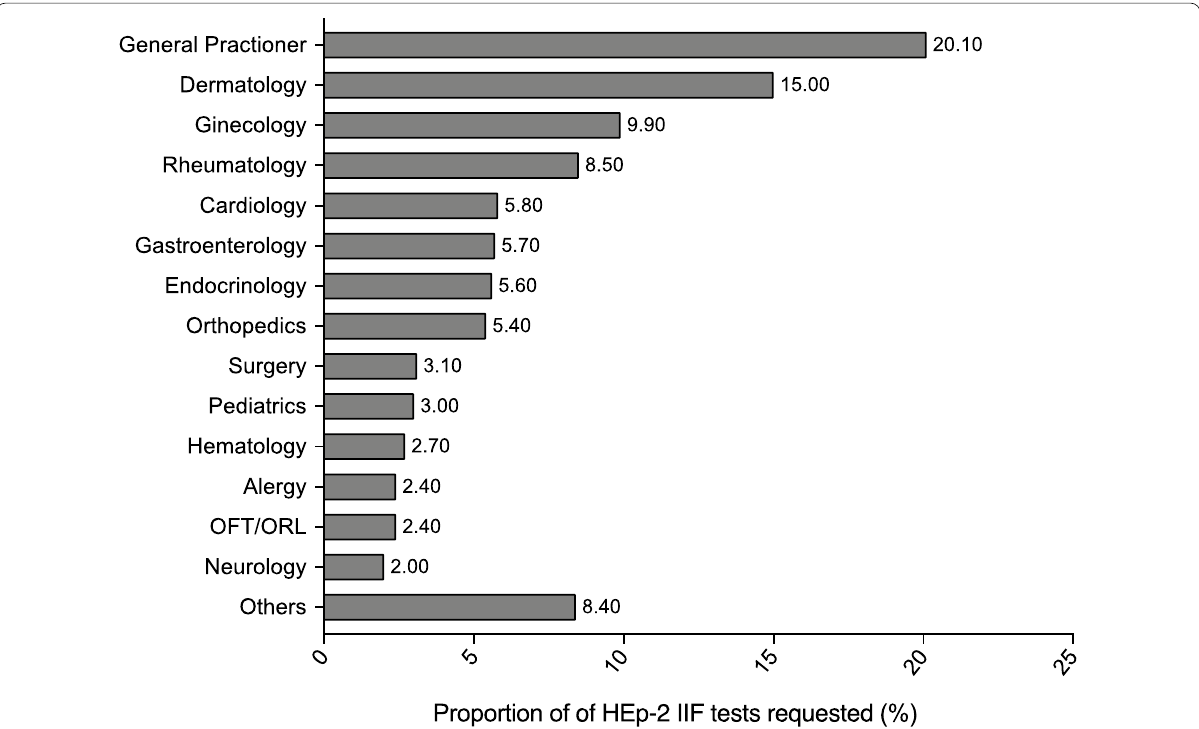
Fig. 4 Proportion (%) of HEp-2 IIF tests requested, according to medical specialties, in 52,117 consecutive serum samples referred to the laboratory from January to June 2017. OFT/ORT: Ophthalmology and